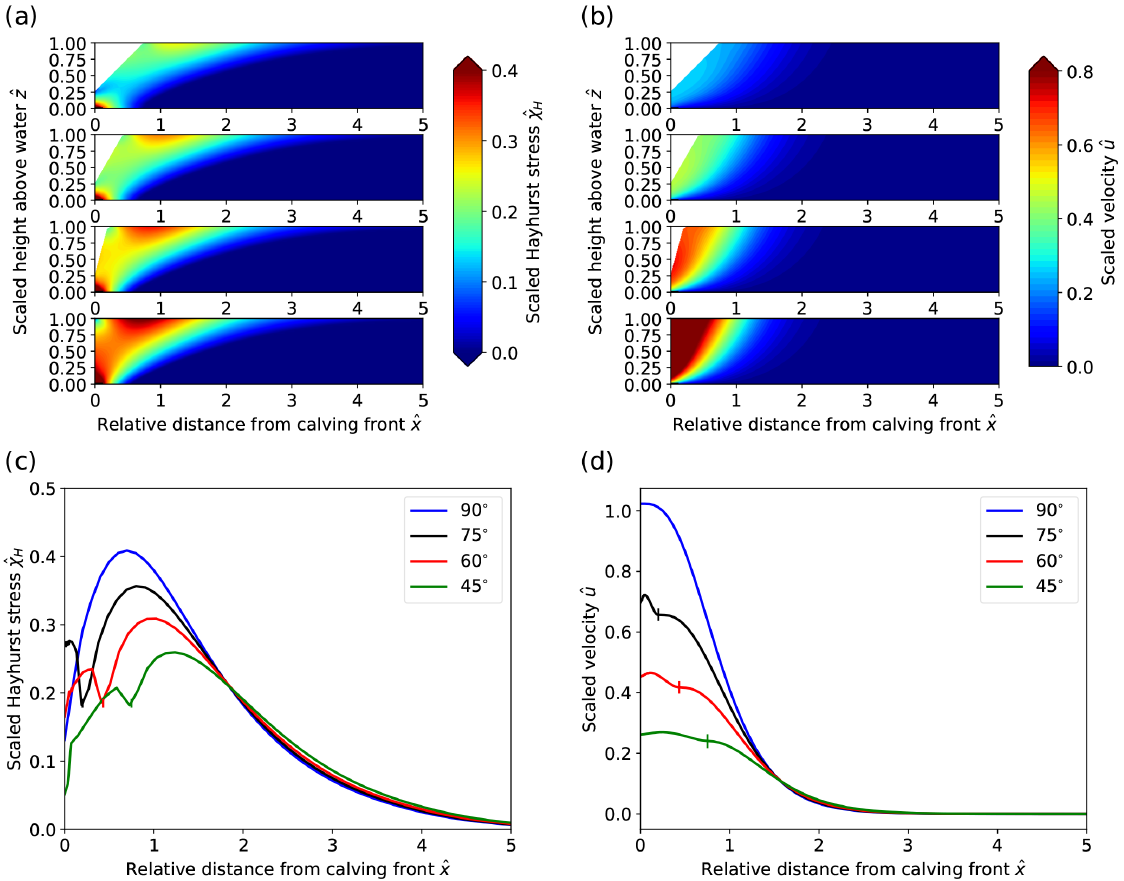
Figure 5. Sensitivity experiment results for varying calving front slope. Panels (a–d) are the same as Fig. 3. In panels (a, b) , the subplots show decreasing calving front slopes from the bottom to the top. In panel (c) , the local minimum of stress close to the calving front is located where the front reaches its maximal height. In panel (d) , vertical lines on the curves for inclined fronts mark the distance at which the maximal surface height is